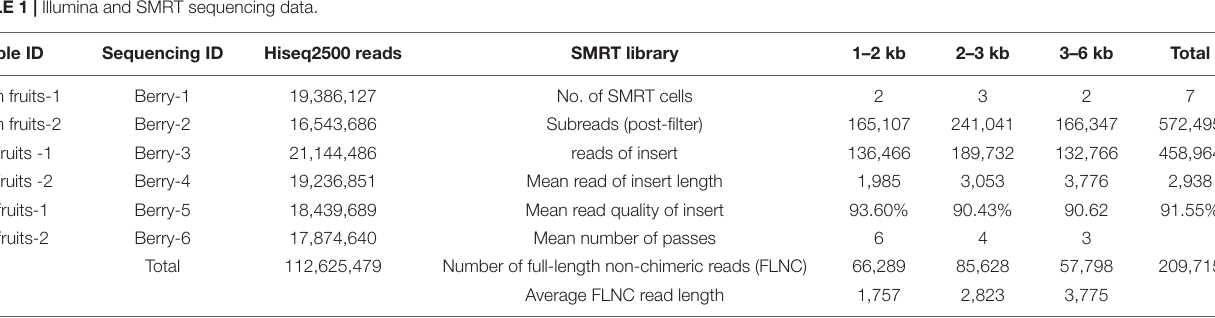
FIGURE 1 | Blueberry (Vaccinium corymbosum “Duke”) fruits of different developmental stages were used in molecular and chemical analyses and Statistical analysis of sequencing data. (A) Green (40 days since flowering), pink (65 days), and blue (80 days) fruits were used in the analyses. Scale bar = 7 mm. Venn diagrams of (B) the number of common and unique sequences and (C) the number of common and unique annotated genes obtained in Illumina and SMRT sequencing. TABLE 1 | Illumina and SMRT sequencing